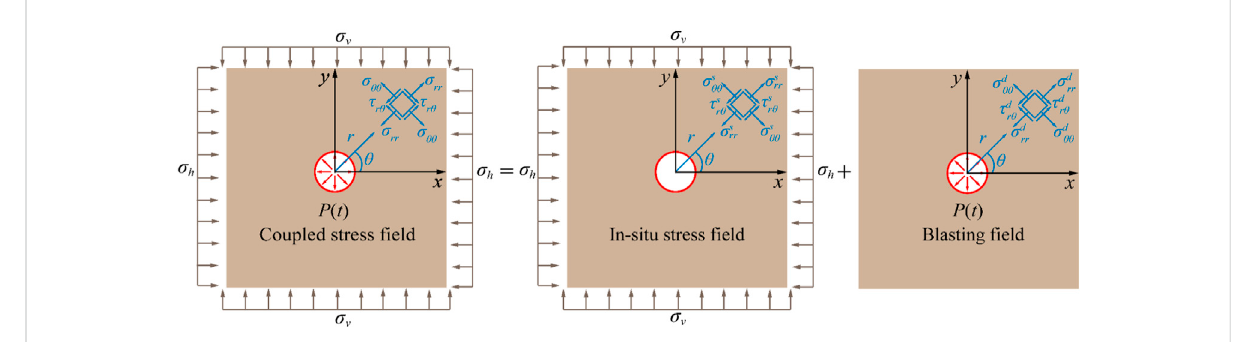
FIGURE 1 Coupling of blasting stress fi eld in deep rock mass (Li X. et al.,